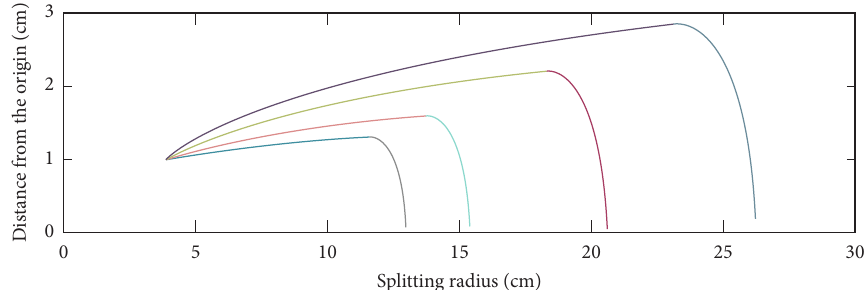
Figure 10: Calculated diffusion